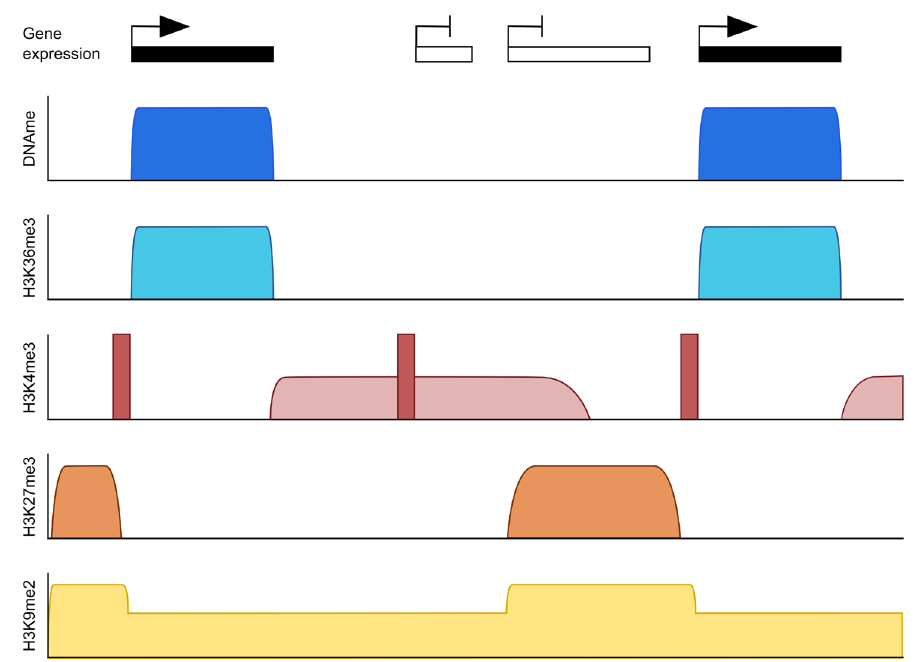
Figure 1. Schematic depicting the typical DNA methylation pattern of fully grown oocytes over active gene bodies and distribution of associated chromatin marks. While H3K36me3 is enriched over methylated domains, H3K27me3 and H3K9me2 are enriched in unmethylated domains. H3K4me3 has an unusual pattern in the oocyte in that peaks can be found at both active and inactive gene promoters (dark red) as well as enrichment over broad domains in untranscribed regions (light red). H3K27me3 is also broadly distributed over non- transcribed regions in oocytes but generally mutually exclusive to